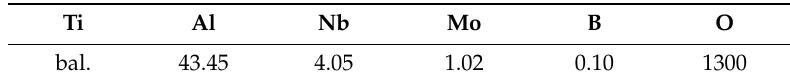
Table 1. Chemical composition of the investigated TNM alloy in at.% after SPS. The oxygen content is stated in mass-ppm. Ti Al Nb Mo B O bal. 43.45 4.05 1.02 0.10